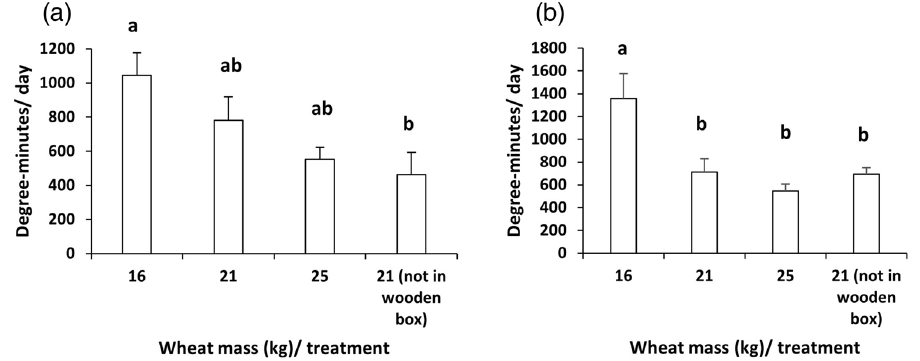
Figure 3. ( a ) Degree-minutes/day ( ◦ C-min, mean + s.e.m.) of 16, 21, and 25 kg wheat of plastic bags inside